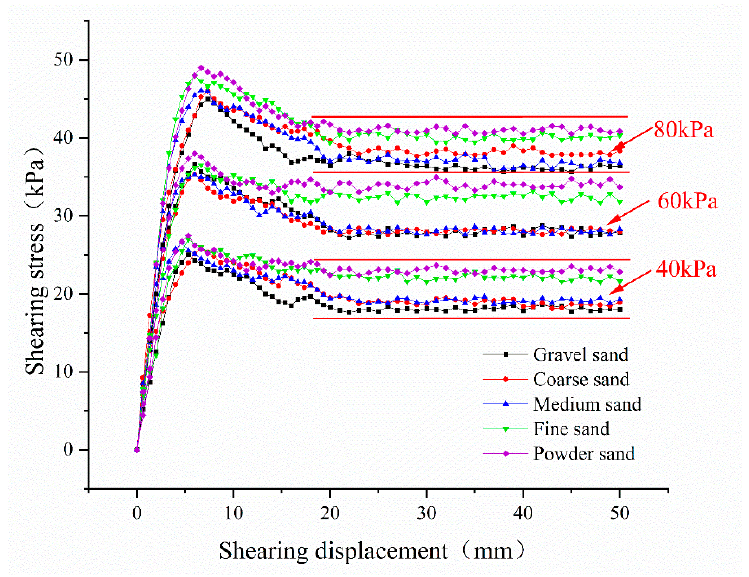
Figure 4. Shear stress-shear displacement curves of different normal stress.